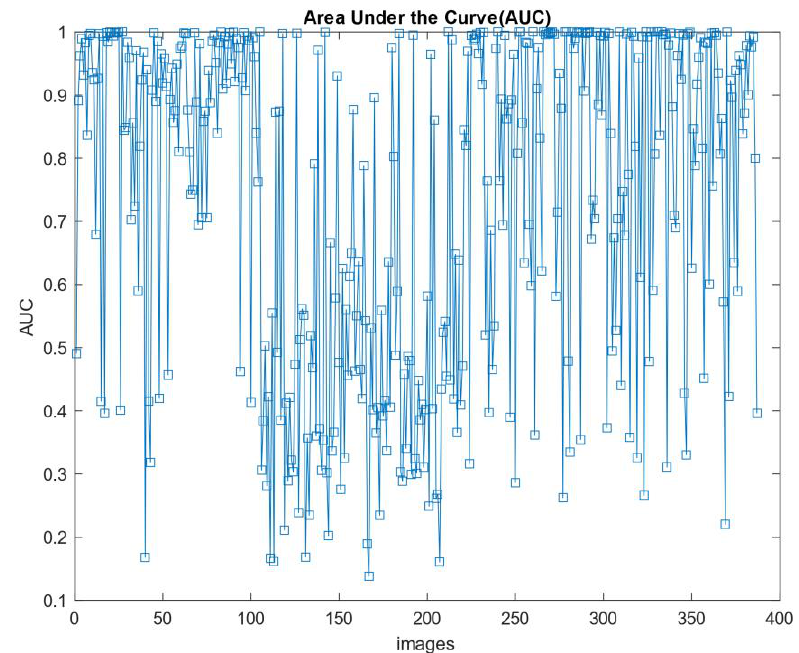
Figure 13. AUC value plot for images used on